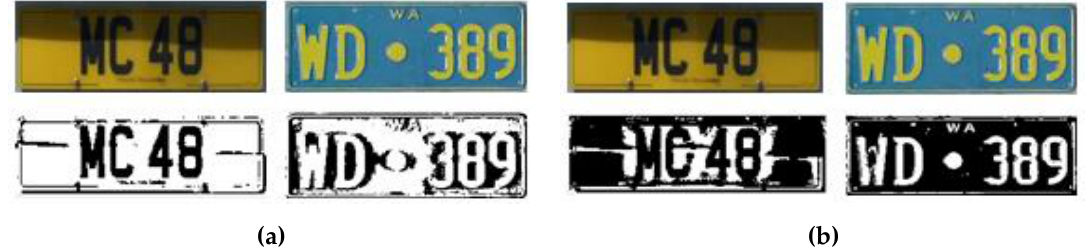
Figure 6. E ff ectiveness of prior knowledge of FG polarity: ( a ) License plate (LP) image with dark Figure 6. Effectiveness of prior knowledge of FG polarity: (a) License plate (LP) image with dark foreground polarity, ( b ) LP image with bright foreground foreground polarity, (b) LP image with bright foreground polarity.